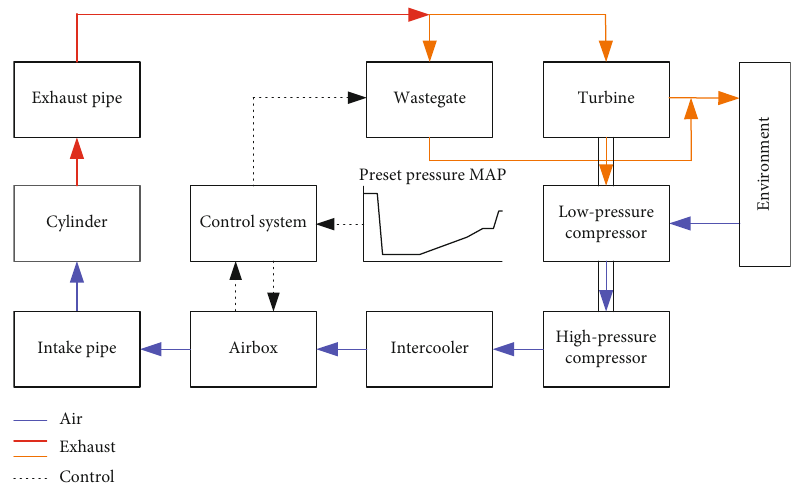
Figure 14: Safety control strategy with added wastegate